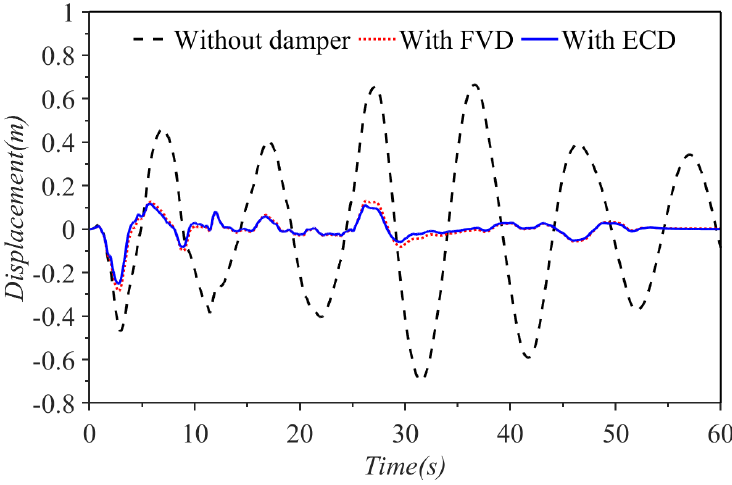
Figure 9. Time − histories of ground motion.